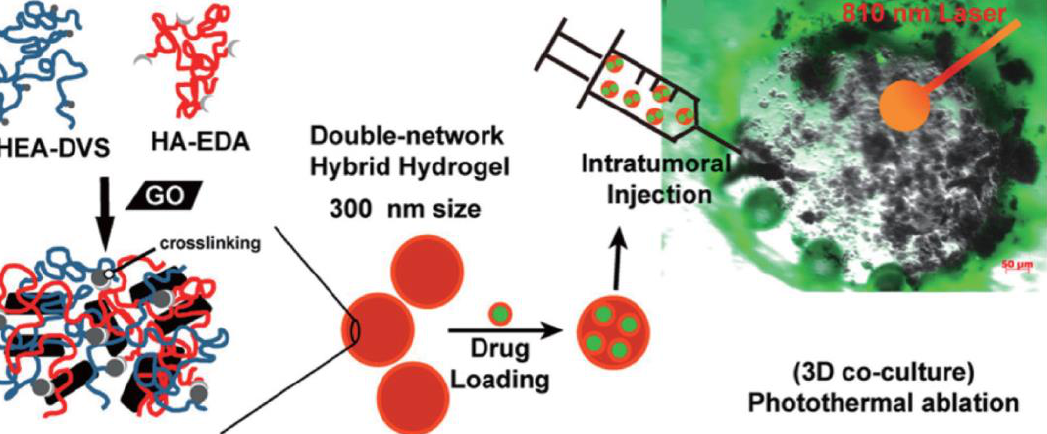
Figure 5. Drug-loaded graphene oxide nanogels for destruction of HCT-116 cells. Reprinted with permission from Ref. [146]. Copyright 2022, American Chemical Society.